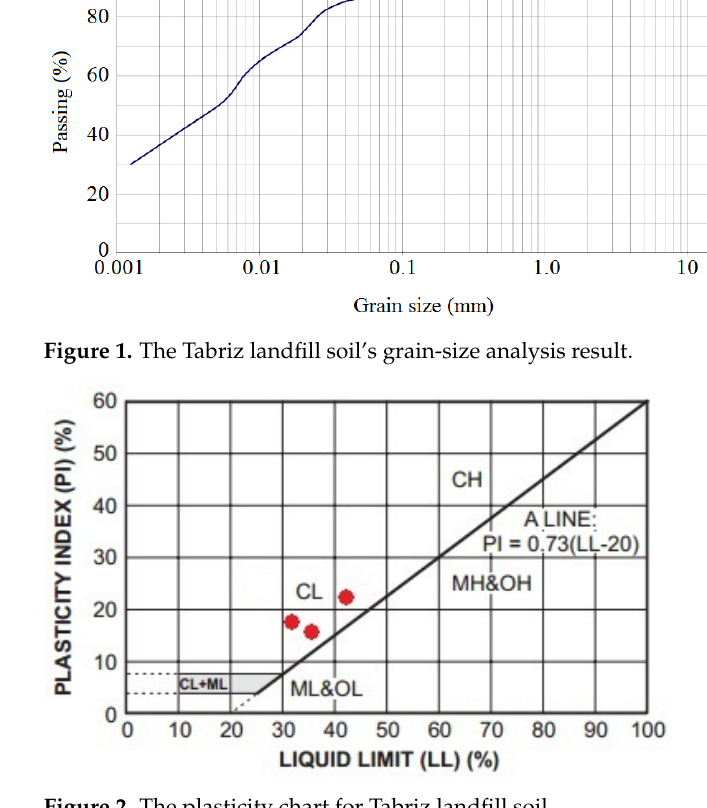
Figure 2. The plasticity chart for Tabriz landfill soil.